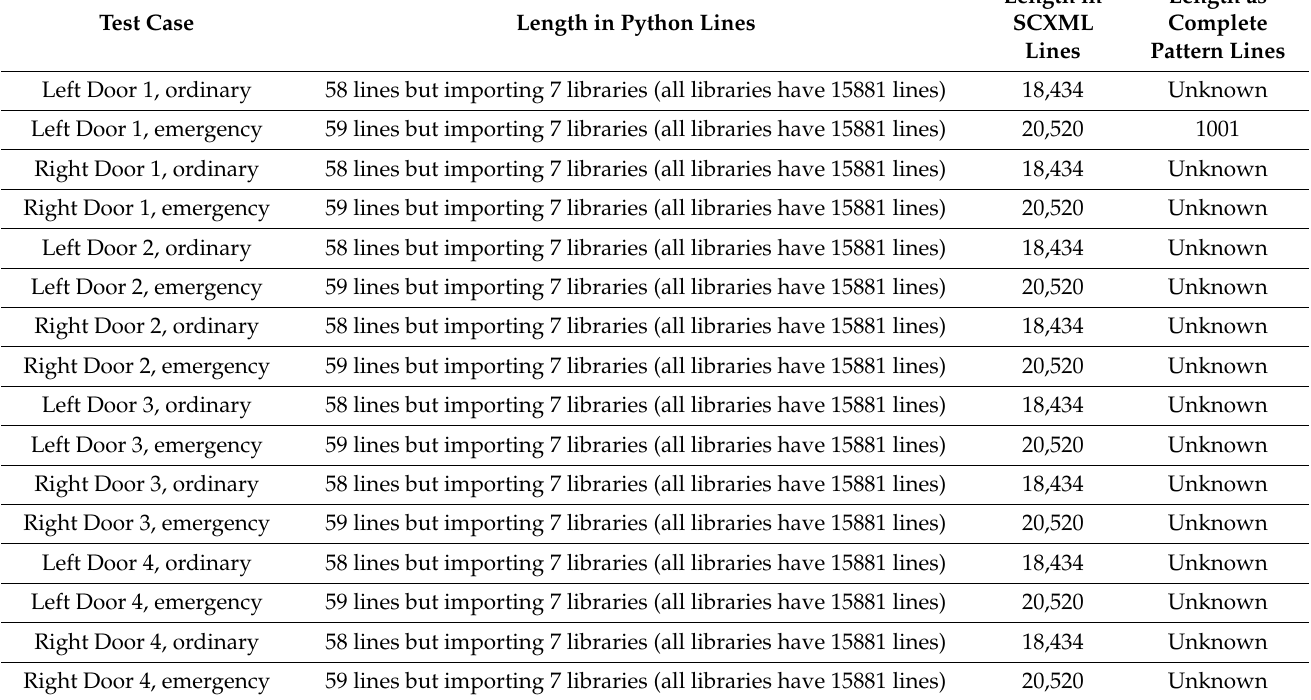
Table 5. Applied test cases as input for the knowledge